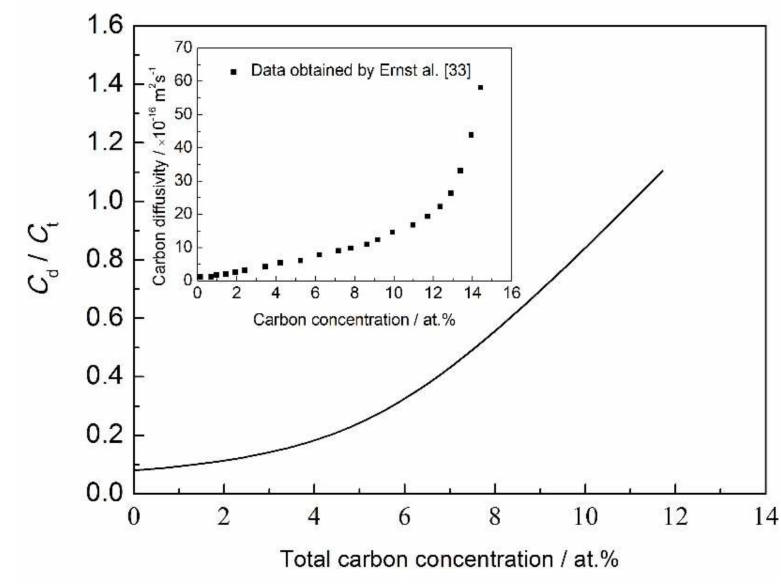
Figure 10. Ratio between carbon concentration at the diffusion sites ( C d ) and carbon concentration at the trapping sites ( C t ) as a function of total carbon concentration. Inset: carbon diffusion coefficient as a function of the total carbon concentration, as determined by Ernst et al.